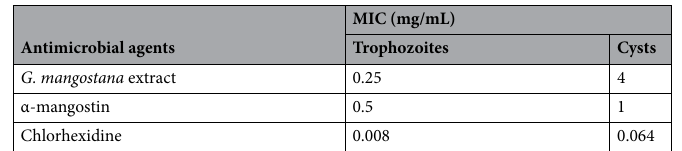
Table 1. Minimal inhibitory concentration (MIC) of G. mangostana extract, α-mangostin and chlorhexidine against A. triangularis trophozoites and cysts.